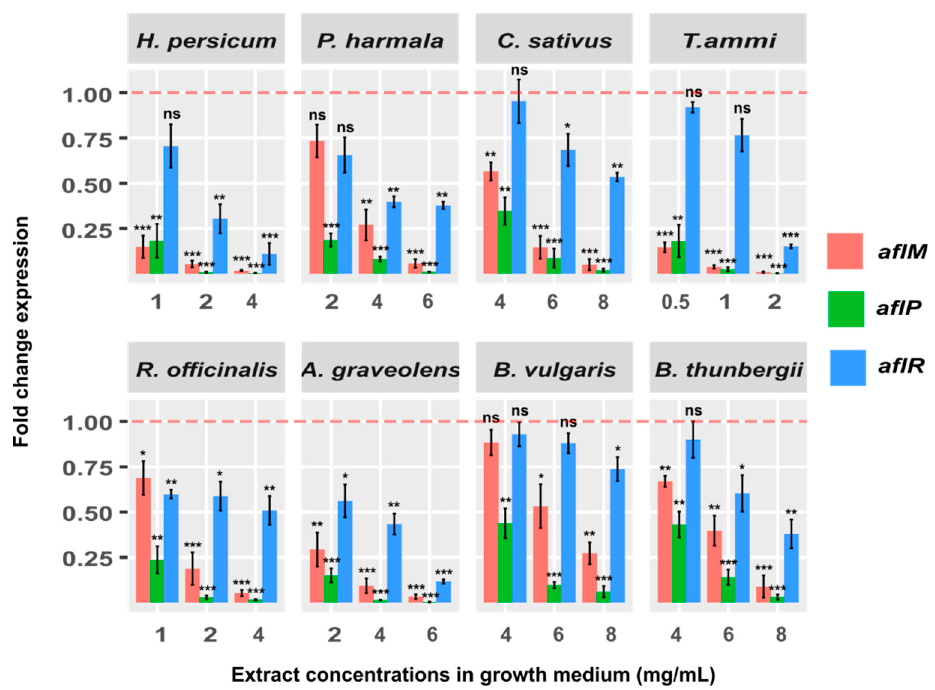
Figure 4. Fold change expression of aflR , aflM and aflP genes in A. flavus NRRL 3357 and in the YES growth medium after 7 days at 28 °C. The red line represents the control expression level. Each bar shows the fold change expression of the genes for all treatment conditions relative to that of the control treatment, where control was contaminated with A. flavus and untreated with extract. For statistical assessment, we compared between the control test and all treatment conditions (different plant extracts and doses) using a two-sample t -test (* p < 0.05; ** p < 0.01; *** p < 0.001; ns: not significant).